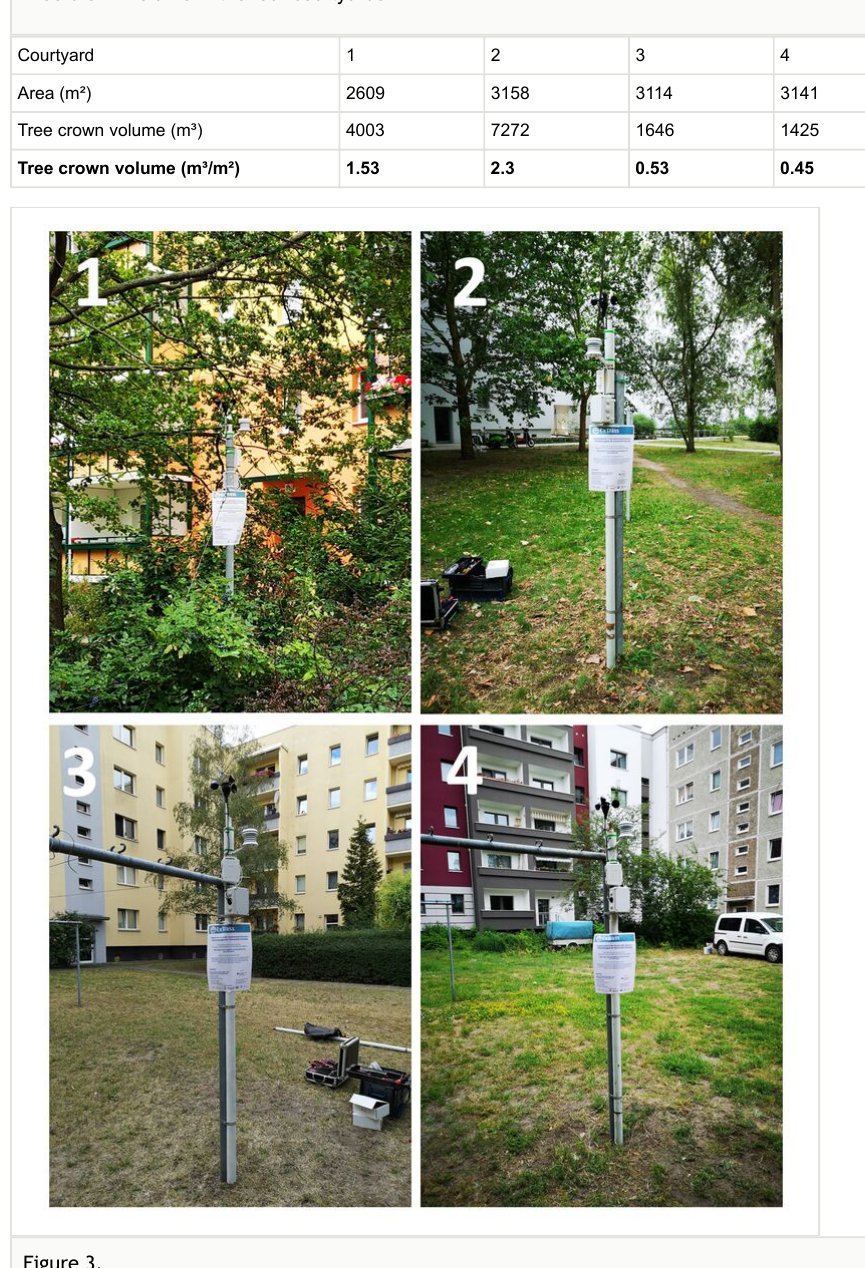
Table 4. Tree crown volume in the four courtyards.